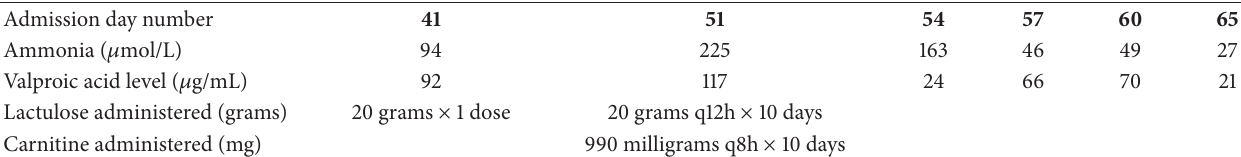
Table 2: Lactulose and carnitine administration and corresponding ammonia and valproic acid